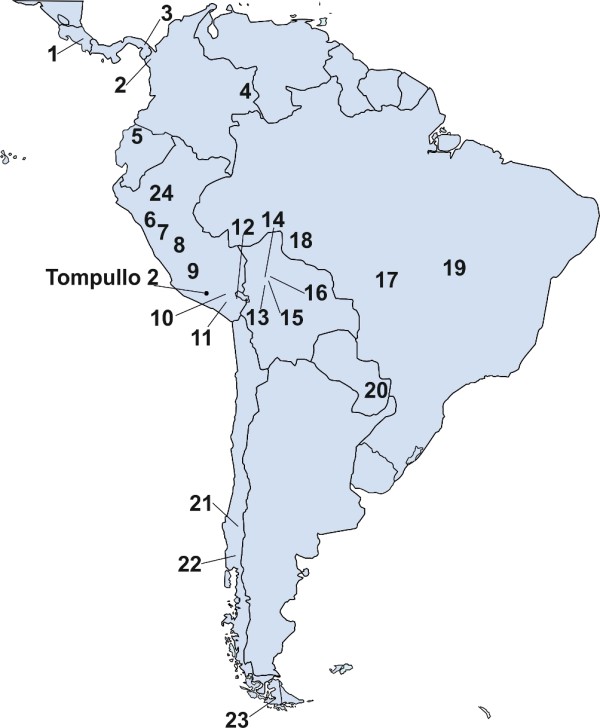
Map of South America with location of Tompullo 2 site and contemporary populations used in this study. 1 – Ngöebe (n = 46) [18], 2 – Embera (n = 44) [19], 3 – Wounan (n = 31) [20], 4 – Guahibo (n = 59) [21], 5 – Cayapa (n = 30) [22], 6 - Yungay ( n = 36) [23], 7 - Ancash (n = 33) [24], 8 – San Martin (n = 23) [25], 9 – Tupe (n = 16) [23], 10 – Tayacaja (n = 61) [25], 11 – Arequipa (n = 22) [25], 12- Puno (Aymara speaking) (n = 14) [23], 13 – Puno (Quechua speaking) (n = 30) [23], 14 – Yuracare (n = 15) [26], 15 - Ignaciano (n = 15) [26], 16 - Trinitario (n = 11) [26], 17 – Movima (n = 12) [26], 18 – Zoro (n = 29) [27], 19 – Gavião (n = 28) [27], 20 – Xavante (n = 24) [27], 21 – Ache (n = 63) [28], 22 – Pehuenche (n = 24) [29], 23 - Mapuche (n = 34) [29], 24 – Yaghan (n = 15) [29].